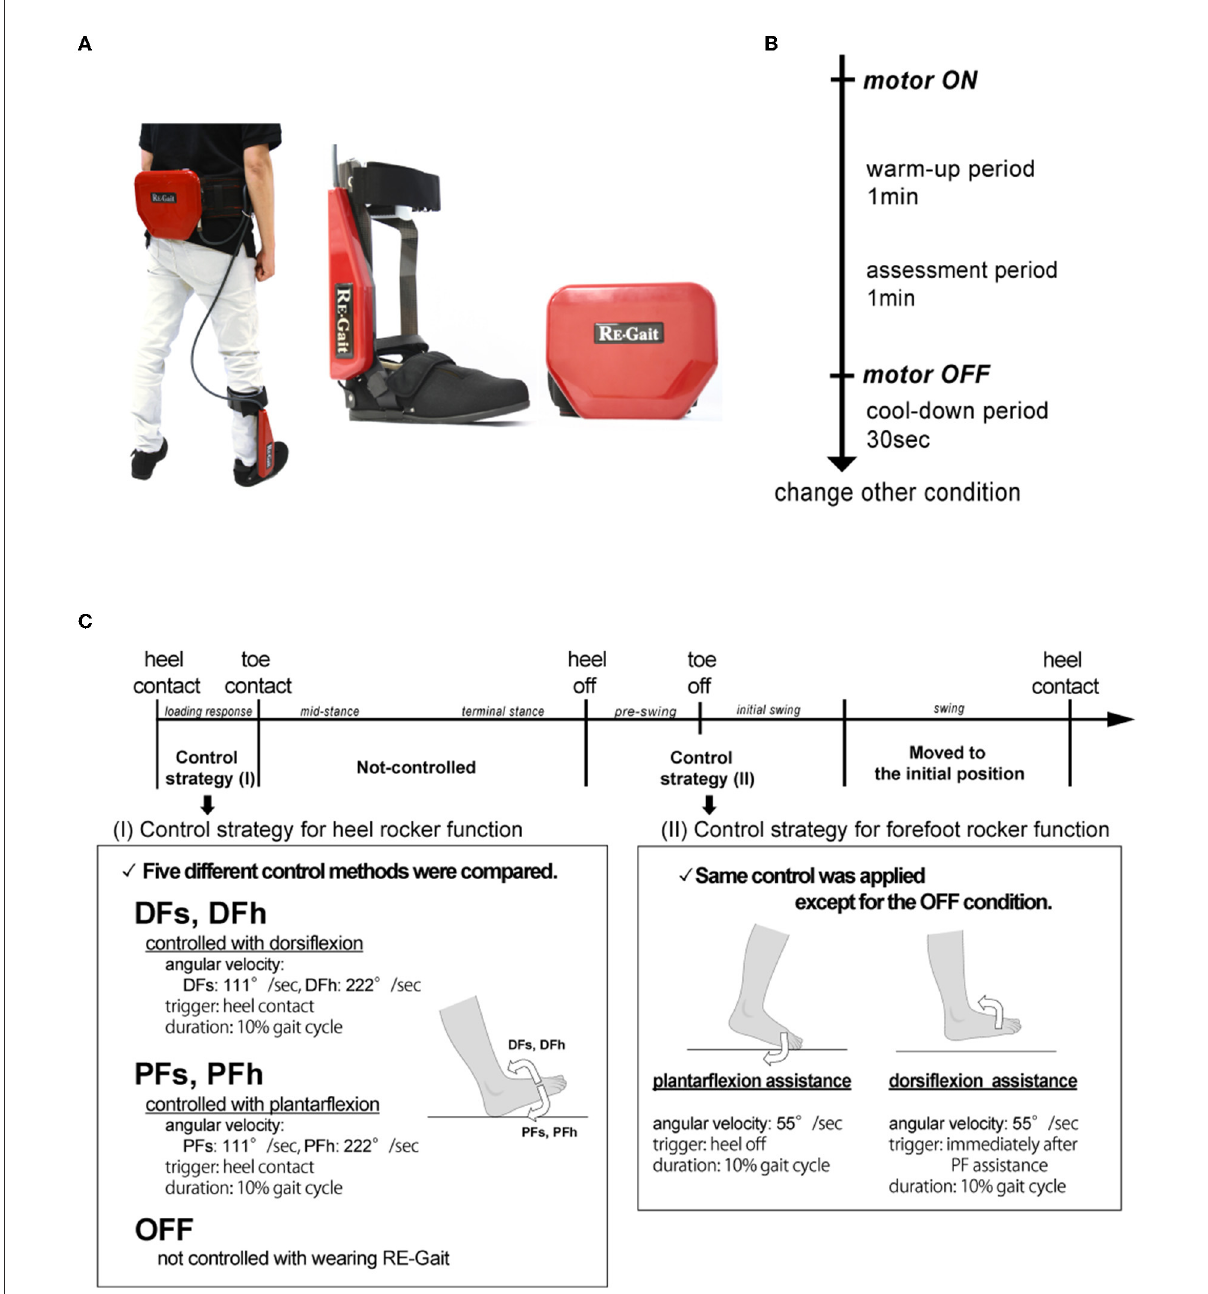
FIGURE1 Experimental protocols. (A) RE-Gait. It consists of a controller (attached with the waist) and an ankle foot orthotic equipped with a motor and two sensors on the toe and heel. It is based on angular velocity control, and the controller generates the necessary torque using an engineering method. (B) Experimental protocol of each walking condition. (C) RE-Gait setting conditions. DFs, controlled with slow ankle dorsiflexion; DFh, controlled with high ankle dorsiflexion; PFs, controlled with slow ankle plantar flexion; PFh, controlled with high ankle plantar flexion; OFF, not